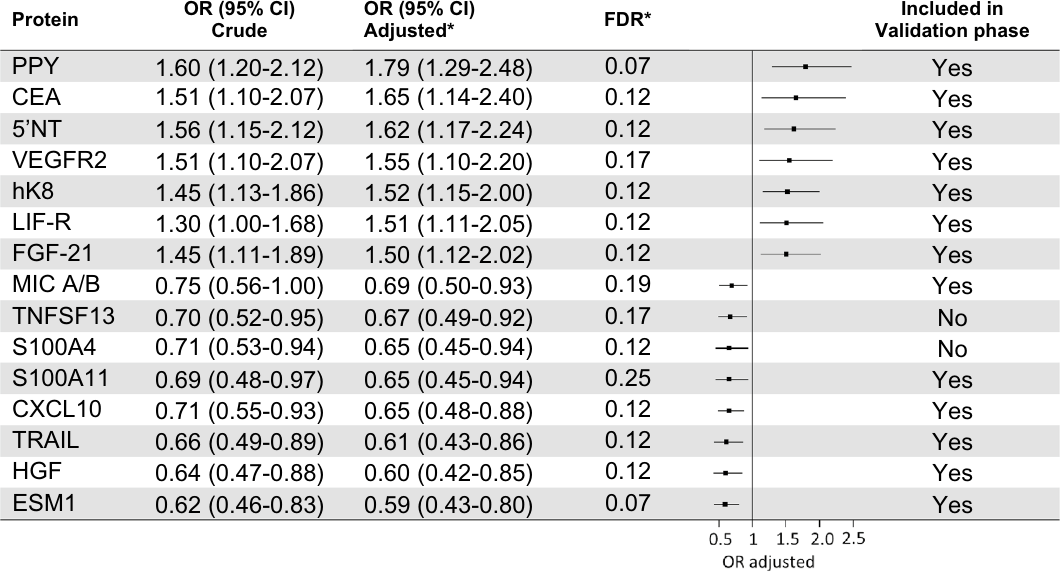
Table 2. Top 15 proteins identified in the discovery phase. *Adjusted for BMI, smoking and education and conditioned on matching criteria (age, sex and sampling date).